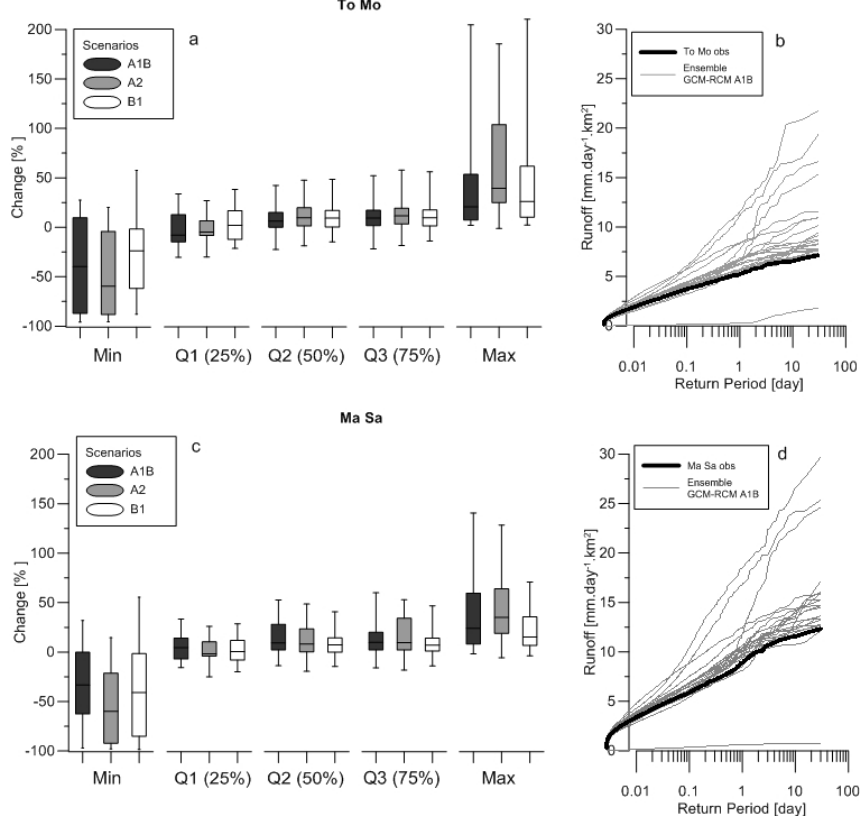
Fig. 9. Projected changes in daily runoff for To Mo and Ma Sa catchments (2045–2065). (a) and (c) relative changes in runoff quantiles (all scenarios), (b) and (d) extreme runoff vs. return period (scenario